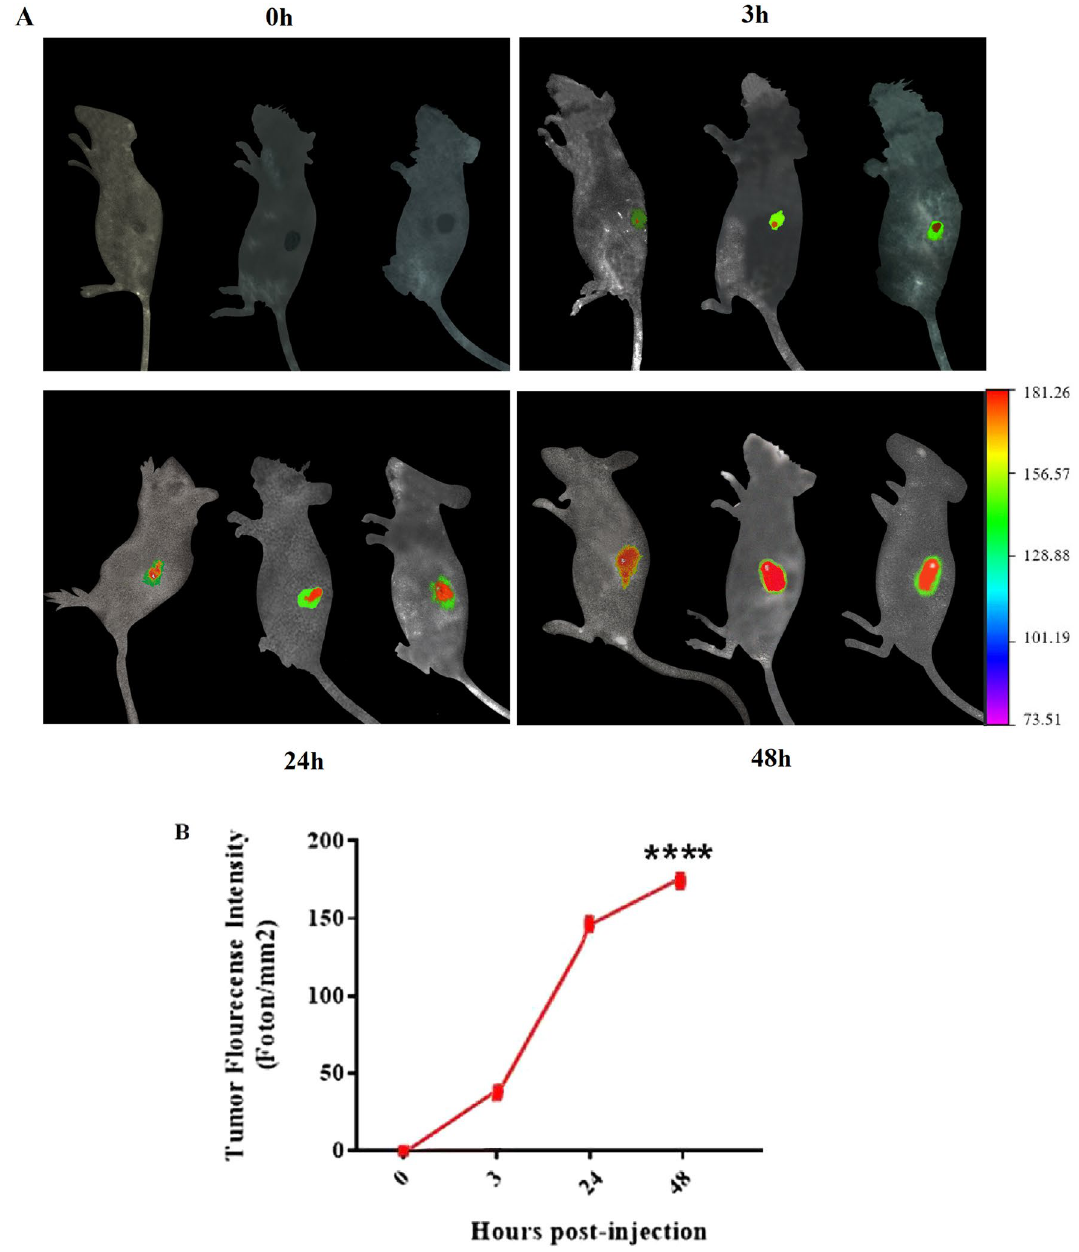
Figure 3. In vivo fluorescence imaging and the associated fluorescent intensity of tumor in C57BL/6 tumor bearing mice. ( A ) Representative whole-body images of ICG-labeled liposomal-EPA at different time points post i . v . administration via lateral tail vein. Fluorescence intensity scale is displayed on the right side of the images. ( B ) Associated fluorescence intensity in tumor site at different time points (n =